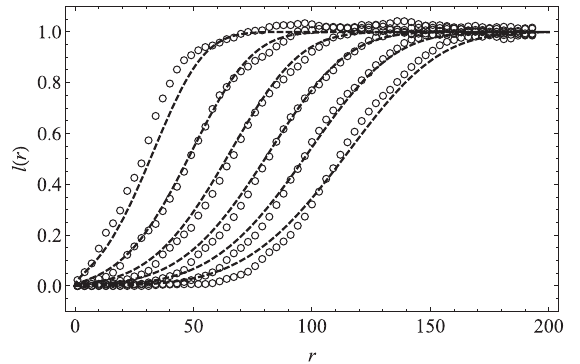
FIG. 17. Dashed lines show theoretical shape of Séguy ’ s curve centered at peak of population density ρ ¼ e − r=R with R ¼ 20 , and with time evolution accelerated by factor of 1.25. Curve computed using Eq. (32) when β ¼ 1 . 1 , σ ¼ 5 , and times are t 0 þ 1 . 25 t , where t ¼ 10 , 20, 30 and t 0 ¼ 4 . 43 . Linear scaling of time determined by maximum likelihood fit of simulation to analytical prediction. Simulation points give equivalent correla- tions in the full model computed from 100 independent simu- lations in a 400 × 400 system at times t ¼ 10 , 20, 30.